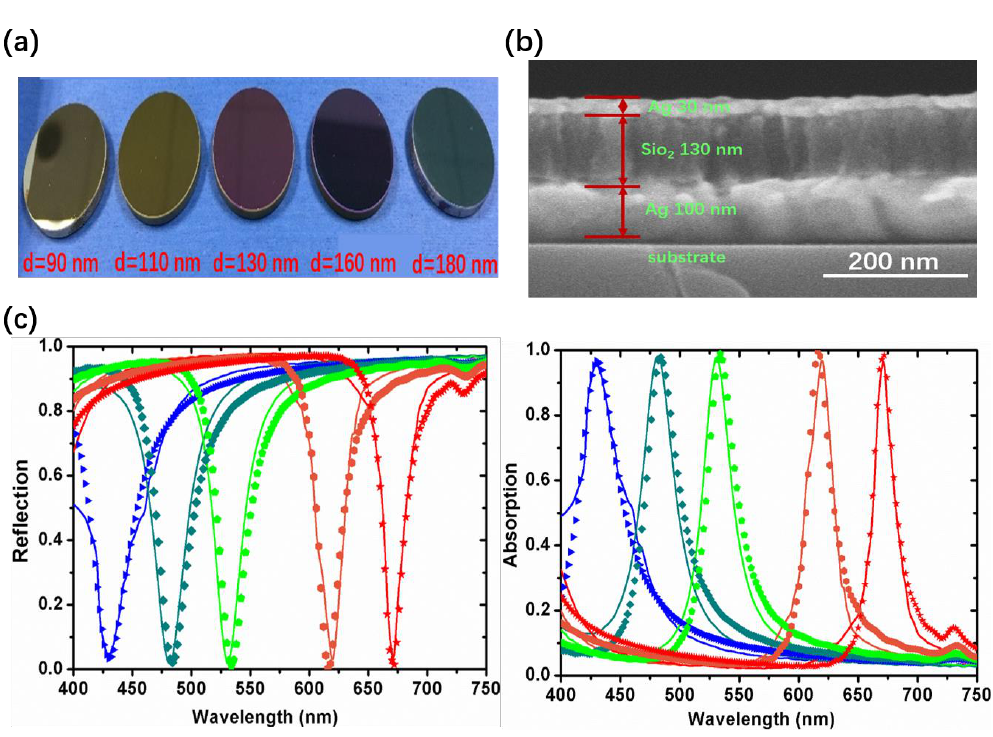
Figure 8. ( a ) Five samples with different SiO 2 thickness: 90, 110, 130, 160, and 180 nm, from left to right; ( b ) SEM image of the structure showing the Ag and SiO 2 layers; ( c ) Simulated and experimental reflection and absorption of five samples; The solid lines are the FDTD simulation results, while the dotted lines are the experimental results. Table 2. The experiment and simulation results at resonance wavelengths for five different thicknesses.